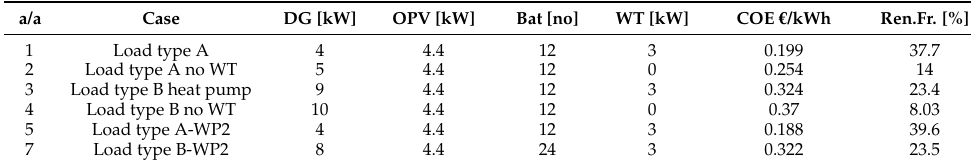
Table 5. Optimization results of base cases configurations.